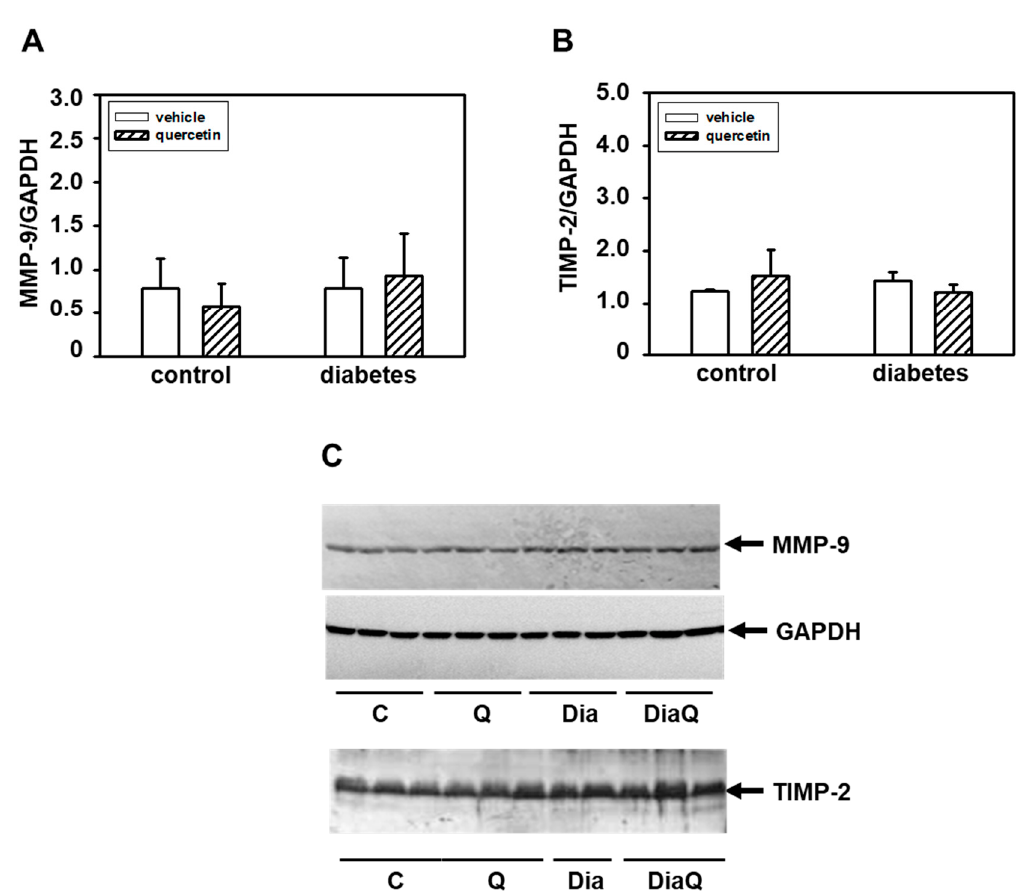
Figure 3. Effects of quercetin treatment on protein levels of matrix metalloproteinase-9 (MMP-9) and matrix metallopro- teinases tissue inhibitor-2 (TIMP-2) in control lean and obese diabetic Zucker Diabetic Fatty (ZDF) rats. ( A ) Quantitative analysis of the MMP-9. Protein levels of MMP-9 in the left ventricle were determined by Western blot analysis using a specific antibody and quantifications of MMP-9 content were normalized to the glyceraldehyde-3-phosphate dehydrogenase (GAPDH) protein levels. Each bar represents mean ± SEM and statistical significance was revealed by Student’s unpaired t -test. ( B ) Quantitative analysis of the TIMP-2. Protein levels of TIMP-2 in the left ventricle were determined by Western blot analysis using a specific antibody and quantifications of TIMP-2 content were normalized to the GAPDH protein levels. Each bar represents mean ± SEM, n = 6–7. Statistical significance was revealed by Student’s unpaired t -test. ( C ) Western blot records showing the protein levels of MMP-9, TIMP-2, and GAPDH. C—control lean vehicle-treated ZDF rats; Q—lean quercetin-treated ZDF rats; Dia—obese diabetic vehicle-treated ZDF rats; DiaQ—obese diabetic quer- cetin-treated ZDF rats.